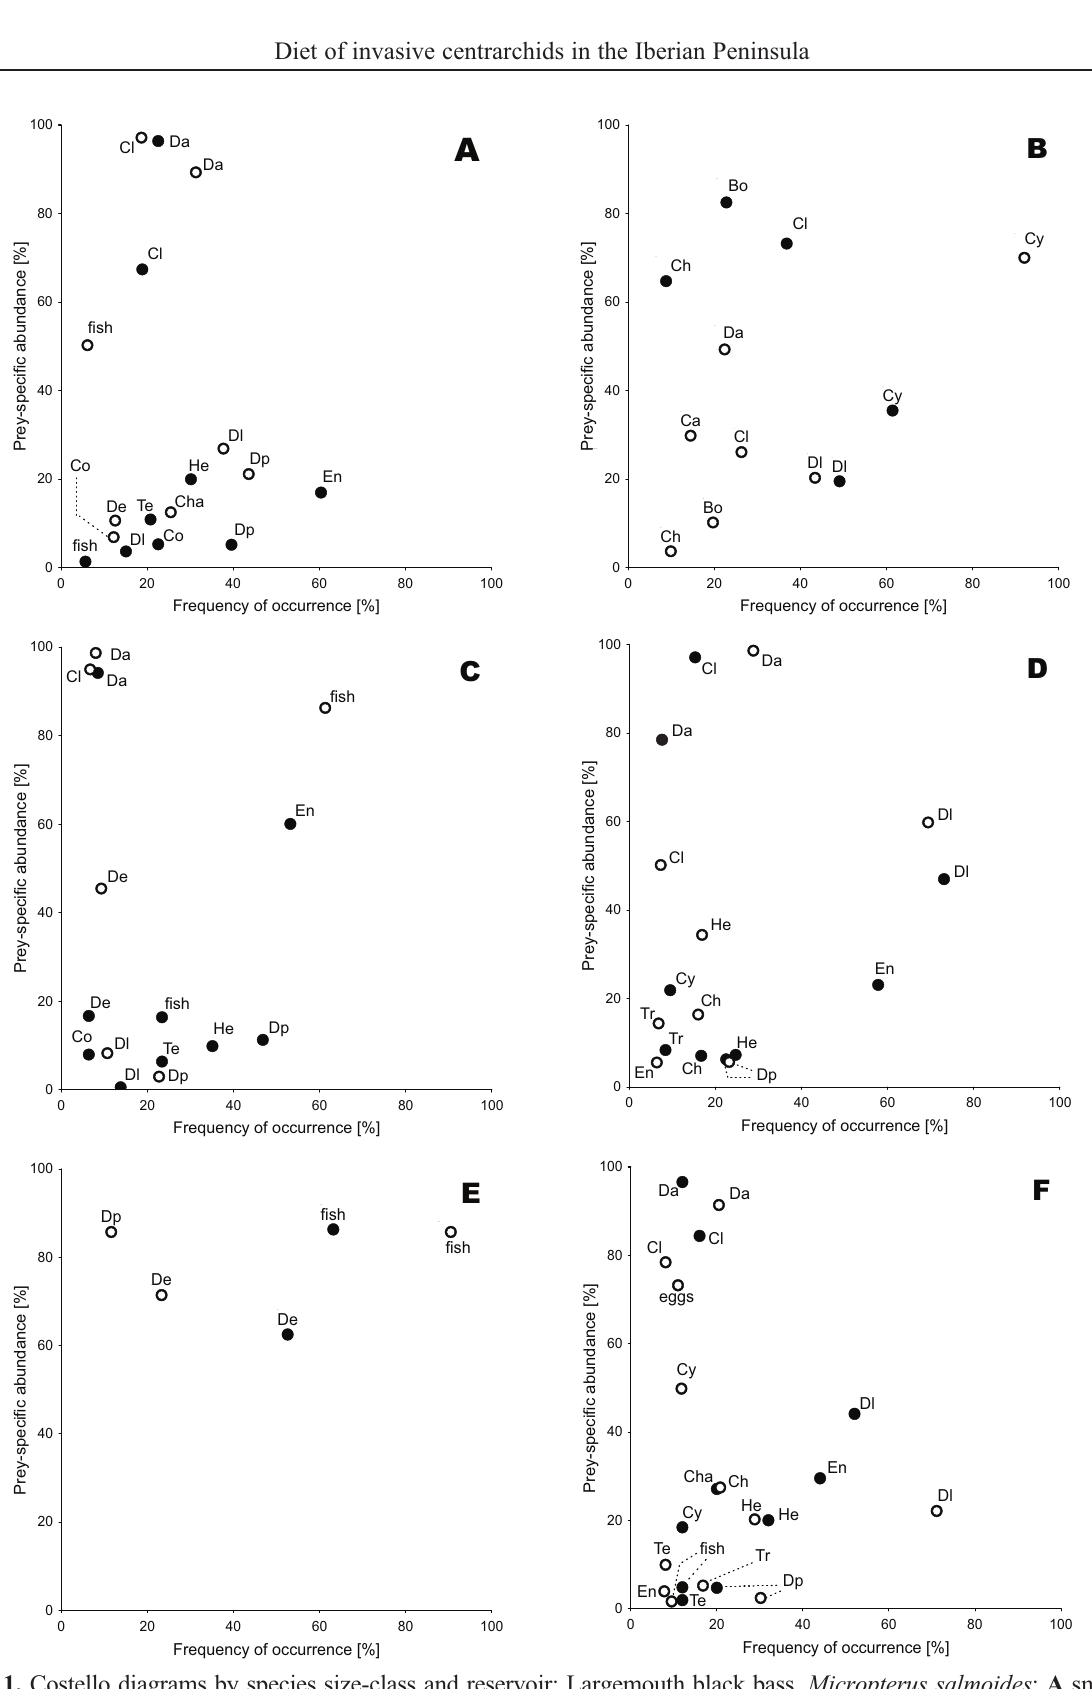
Fig. 1. Costello diagrams by species size-class and reservoir; Largemouth black bass, Micropterus salmoides : A small, C intermediate, E large; Pumpkinseed, Lepomis gibbosus : B small, D intermediate, F large; Black dot = Tapada Grande Reservoir, white dot = Monte Novo Reservoir; Prey codes: Bo = Bosmina, Ca = Calanoida, Ch = Chydorus , Cha = Chaoborus , Cl = other Cladocera, Co = Copepoda, Cy = Cyclopoida, Da =Daphnia , De = Decapoda, Dl = Diptera larvae (except Chaoborus ), Dp = Diptera pupae (except Chaoborus ), En = Ephemeroptera nymps, He = Heteroptera, Te = Terrestrial insects, Tr = Trichoptera larvae; Only prey with frequency of occurrence > 5.0% are